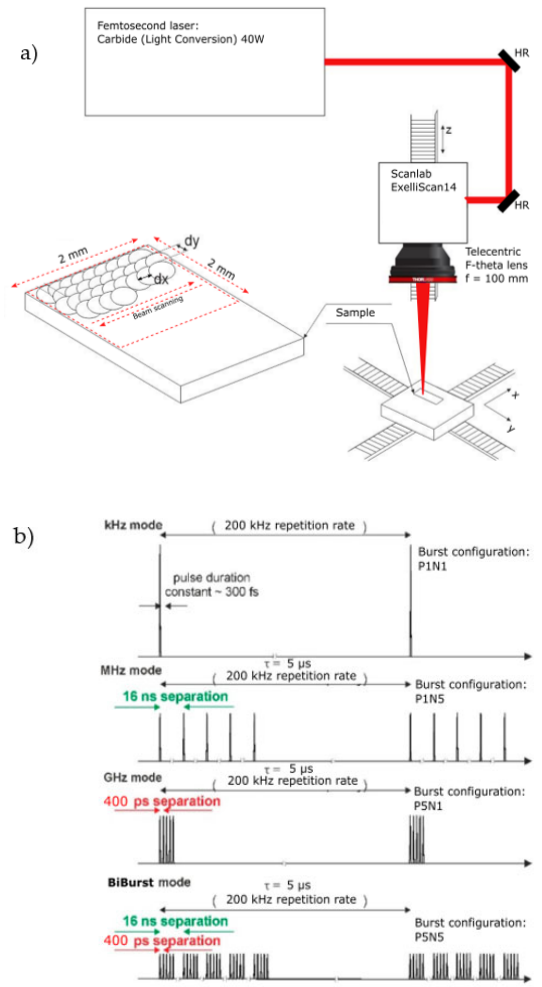
Figure 1. ( a ) Experimental setup for ablation of Stainless steel. The bottom part shows the fabrication algorithm used. ( b ) Illustration of the burst modes generated by the laser. The 16 ns temporal sepa ‐ ration equates to a MHz, whereas the 400 ps to a GHz repetition rate. The BiBurst mode is a combi ‐ nation of the MHz and GHz modes and produces several pulses temporally separated by 400 ps, for all the different burst modes.